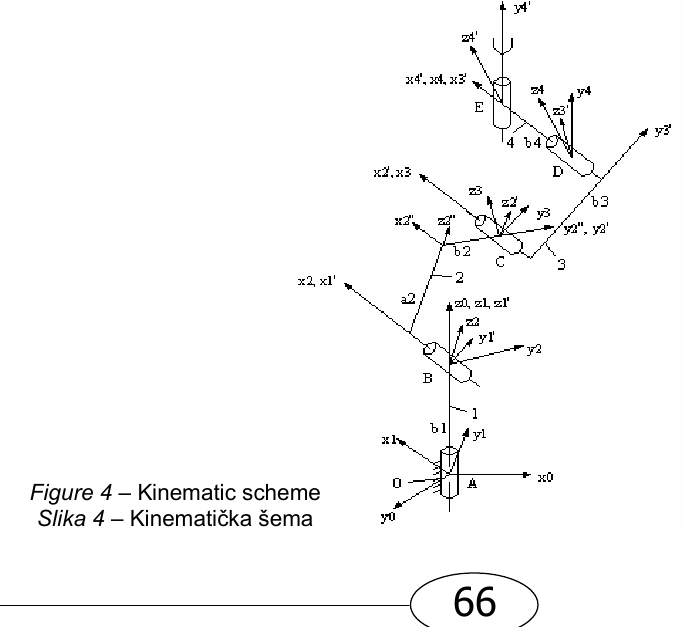
Figure 4 – Kinematic